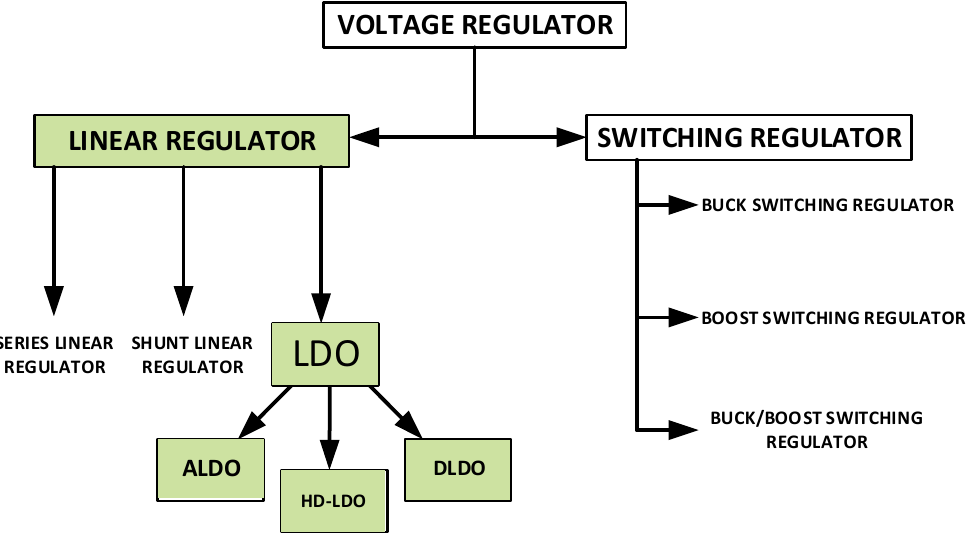
Figure 3. Classification of Voltage Regulator.